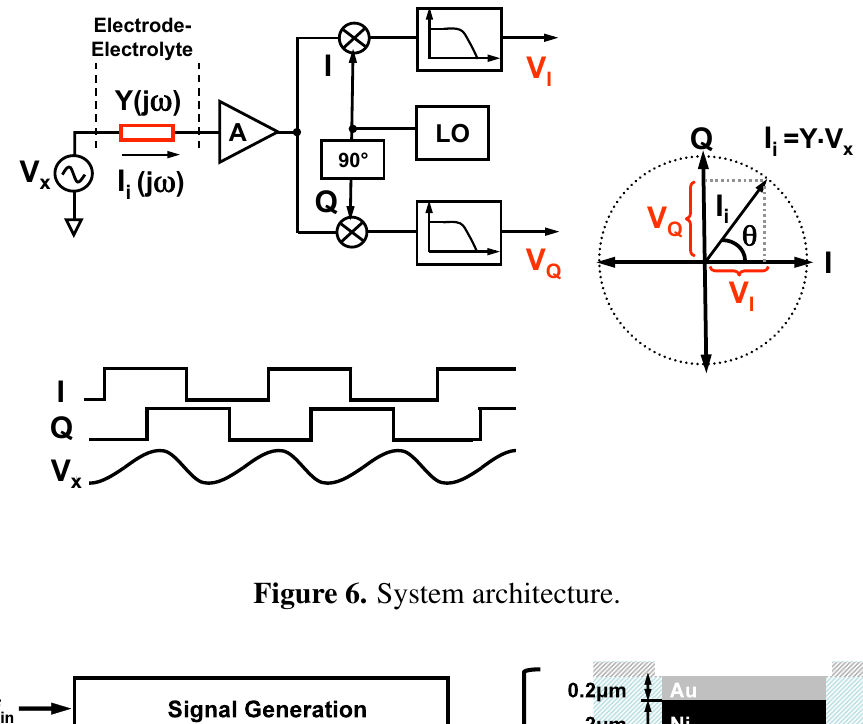
Figure 5. Coherent detection architecture for impedance measurement.